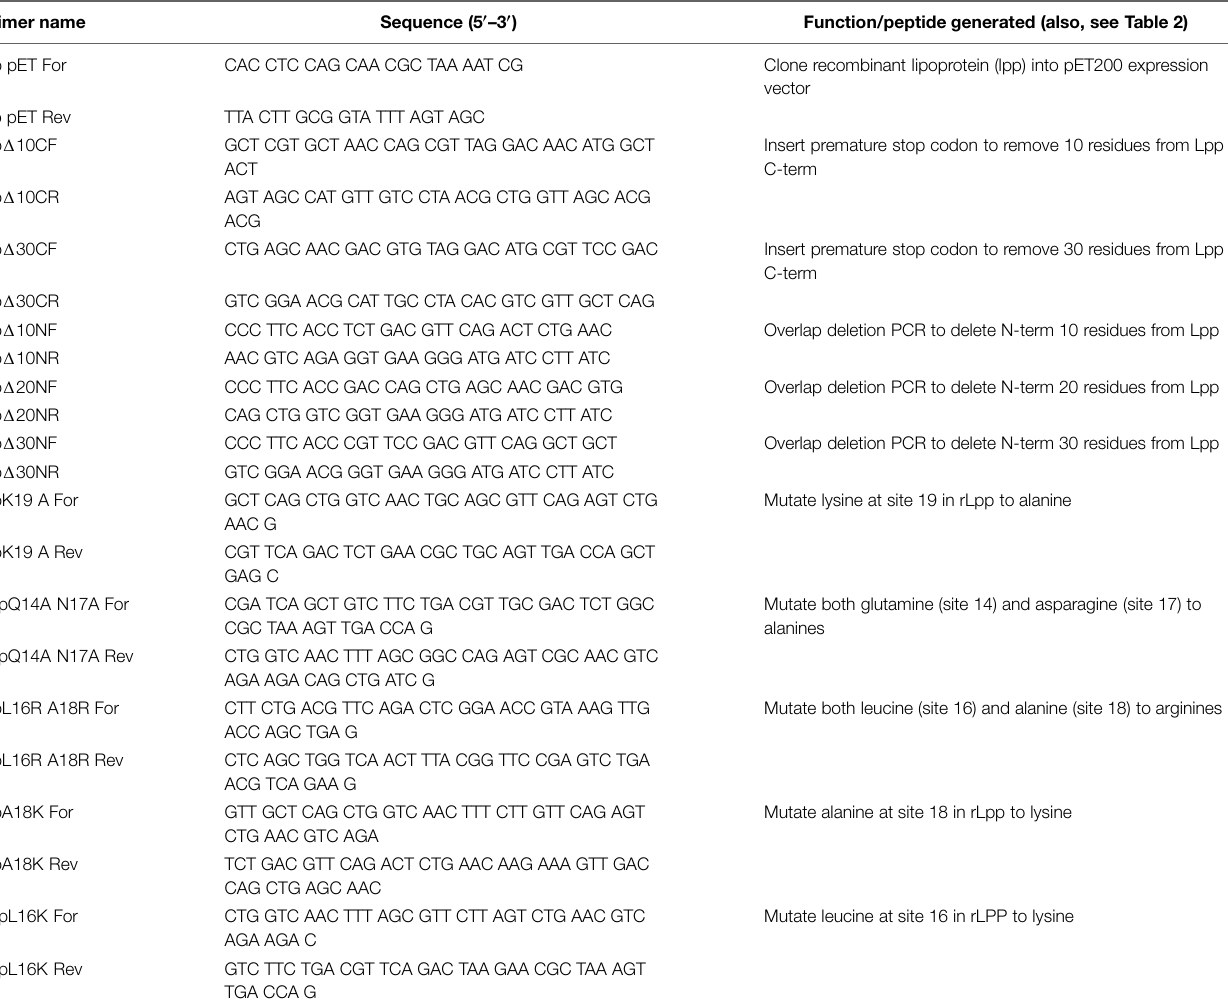
TABLE 1 | A list of primers generated in this study and their